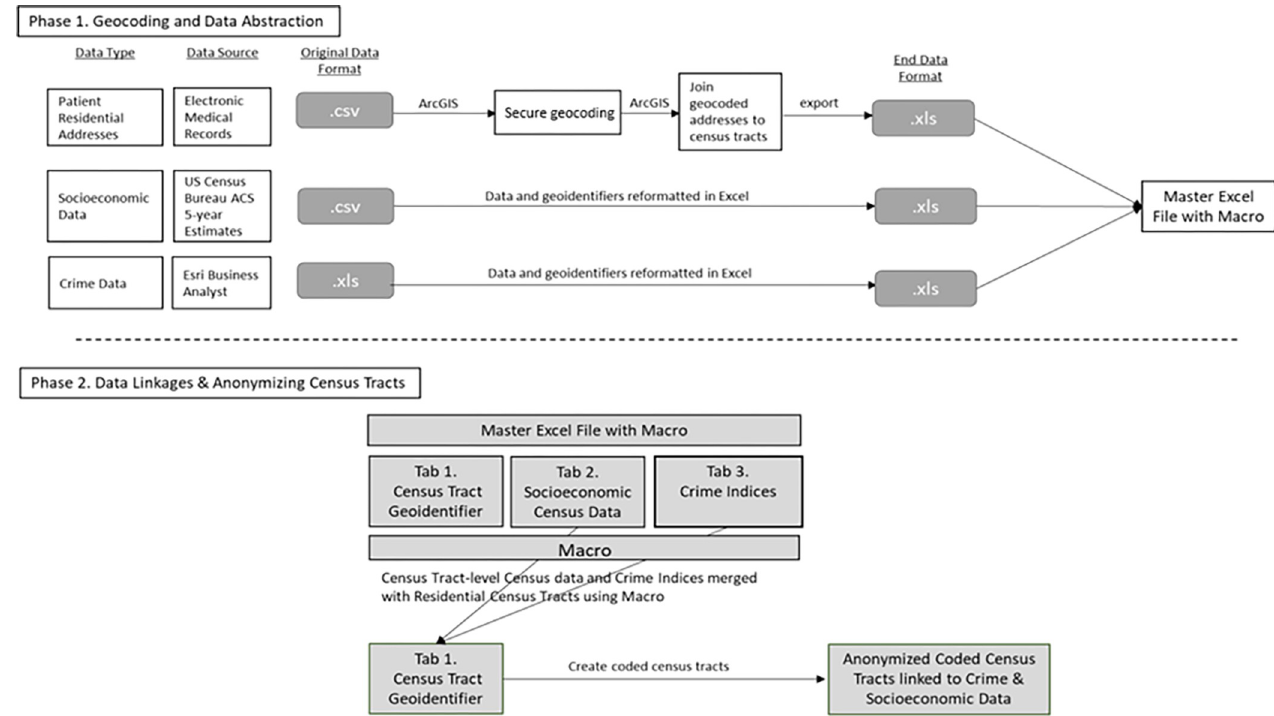
Fig 1. Protocol flow diagram. Visual depiction of each phase of the geocoding and data linkages protocol. ACS: American Community Survey.